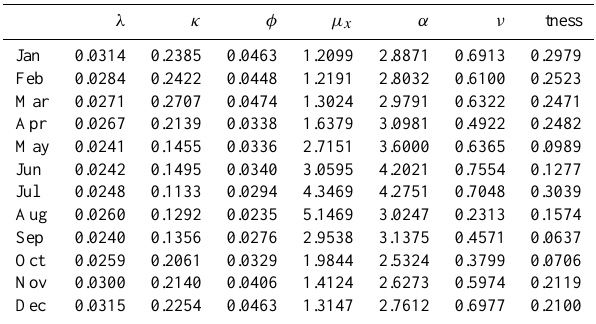
Table 8. Final parameters resulting from calibration with OF3 found by each of the optimization methods.